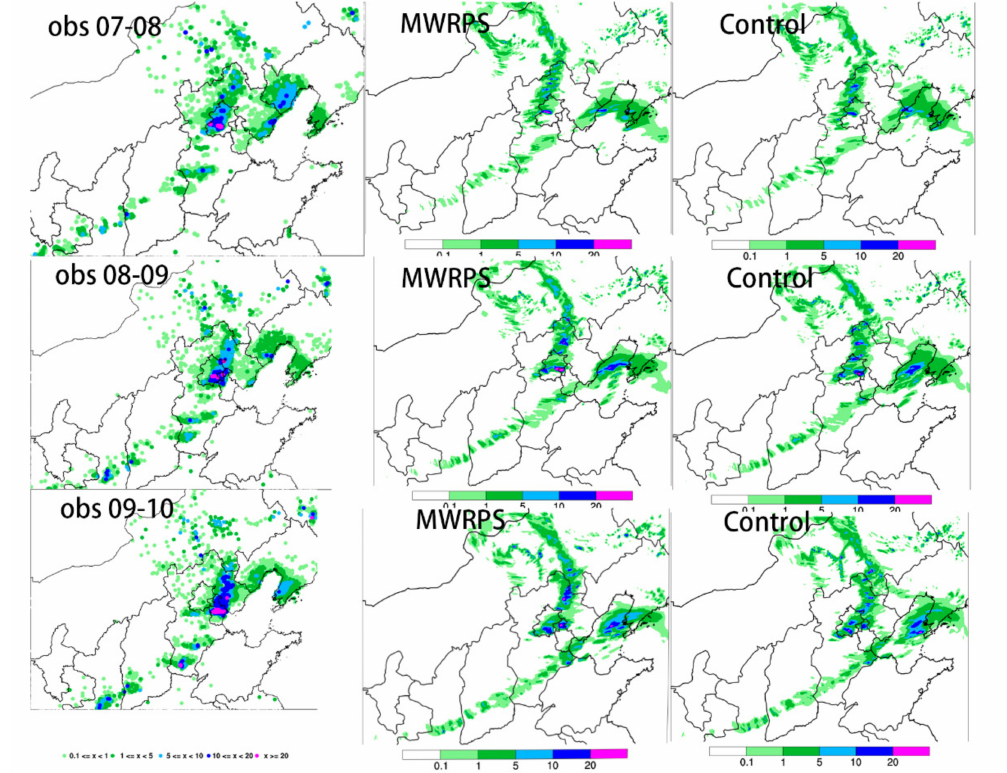
Figure 6. One-hour accumulated precipitation during the periods 0700 UTC–0800 UTC, 0800 UTC– 0900 UTC, and 0900 UTC–1000 UTC on 21 May, 2020: observation ( left column), D02 forecasting in MWRPS experiment ( middle column), and D02 forecasting in Control experiment ( right